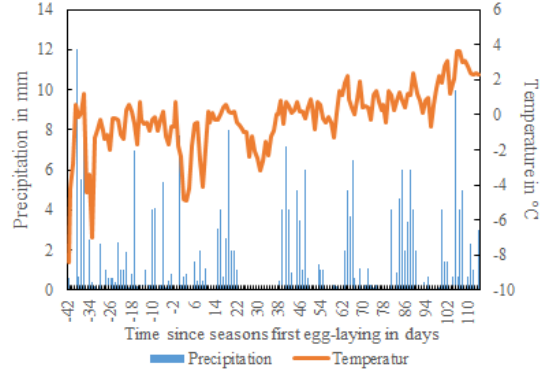
Figure 9. Season 2016/17: precipitation and temperature.. Source: rp5.ru